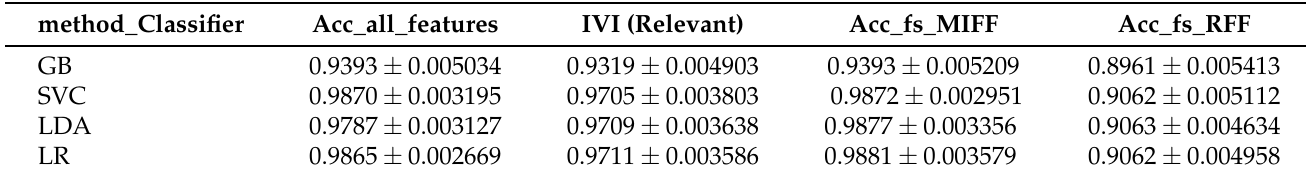
Table 1. Statistical results for accuracy of the ML methods in synthetic dataset. Mean and standard deviation of the results for one-hundred-resample analysis. In rows are the results for the different ML methods. In columns are the different set of features included in the analysis. Columns from left to right, represent all available features, IVI-relevant features, MIFF features, and RFF